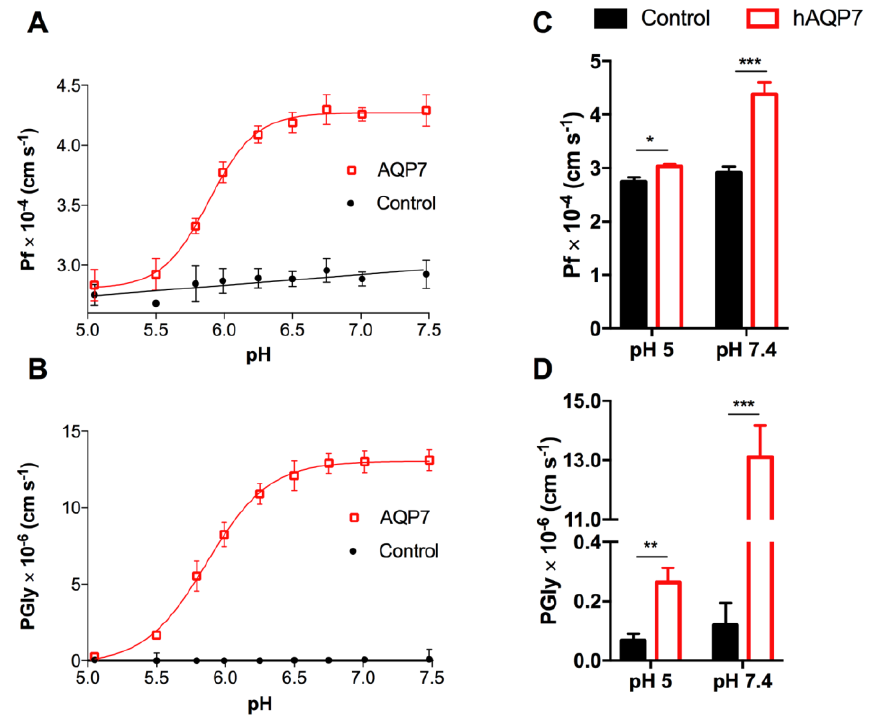
Figure 2. pH-dependence of hAQP7 permeability. ( A ) P f and ( B ) P Gly dependency of control and hAQP7 cells at pH 5.0–7.5. ( C ) P f and ( D ) P Gly at pH 5.0 and pH 7.4. pH-dependence of hAQP7 was analyzed by fitting the experimental data to a Hill equation from where the p K a values were estimated. Permeability assays were performed at 23 °C. Data are mean ± SEM of four independent experiments. * p < 0.05, ** p < 0.01, *** p < 0.001.